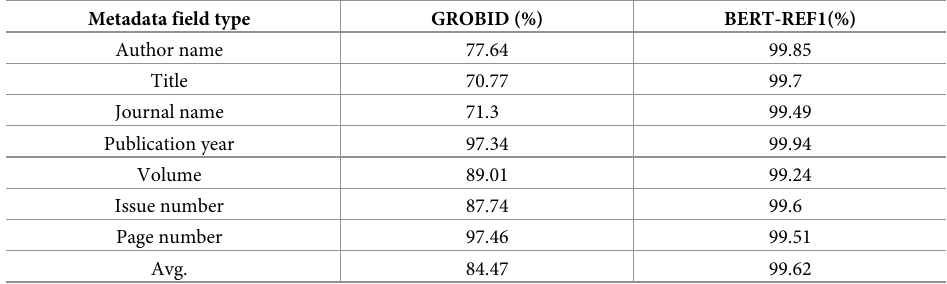
Table 10. Accuracy of the metadata field values extracted from 12,887 new references using BERT-REF1 and GROBID.